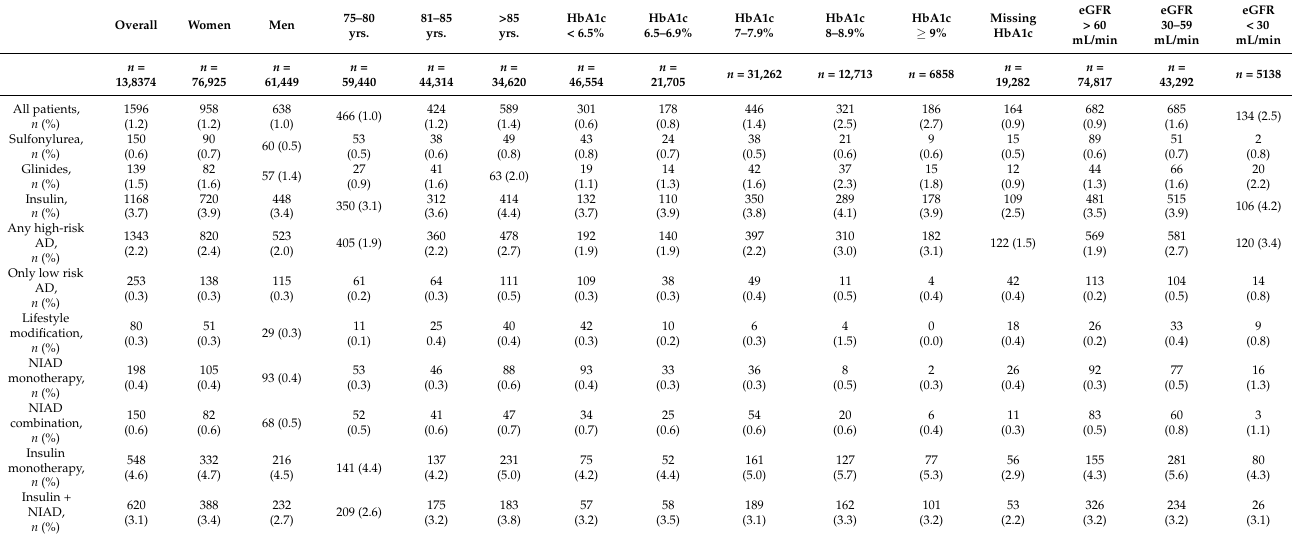
Table 3. Frequency of registered hypoglycemia in patients treated with drugs associated with a higher risk of hypoglycemia (insulin, sulfonylureas, or glinides) and treatment steps according to sex and age subgroups, the categories of HbA1c, and estimated Glomerular Filtration Rate.